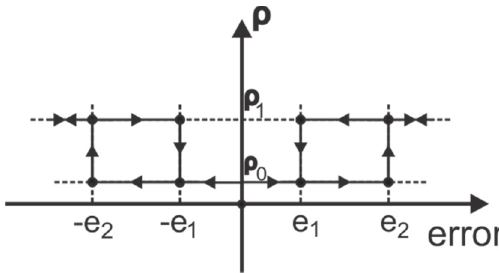
Figure 1. The self-tuning mechanism of the control penalty based on a sharp hysteresis loop.